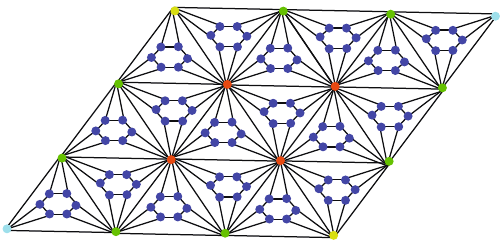
Figure 3: Fourth type of rectangular hex-derived network (RHDN4 (4,4)).